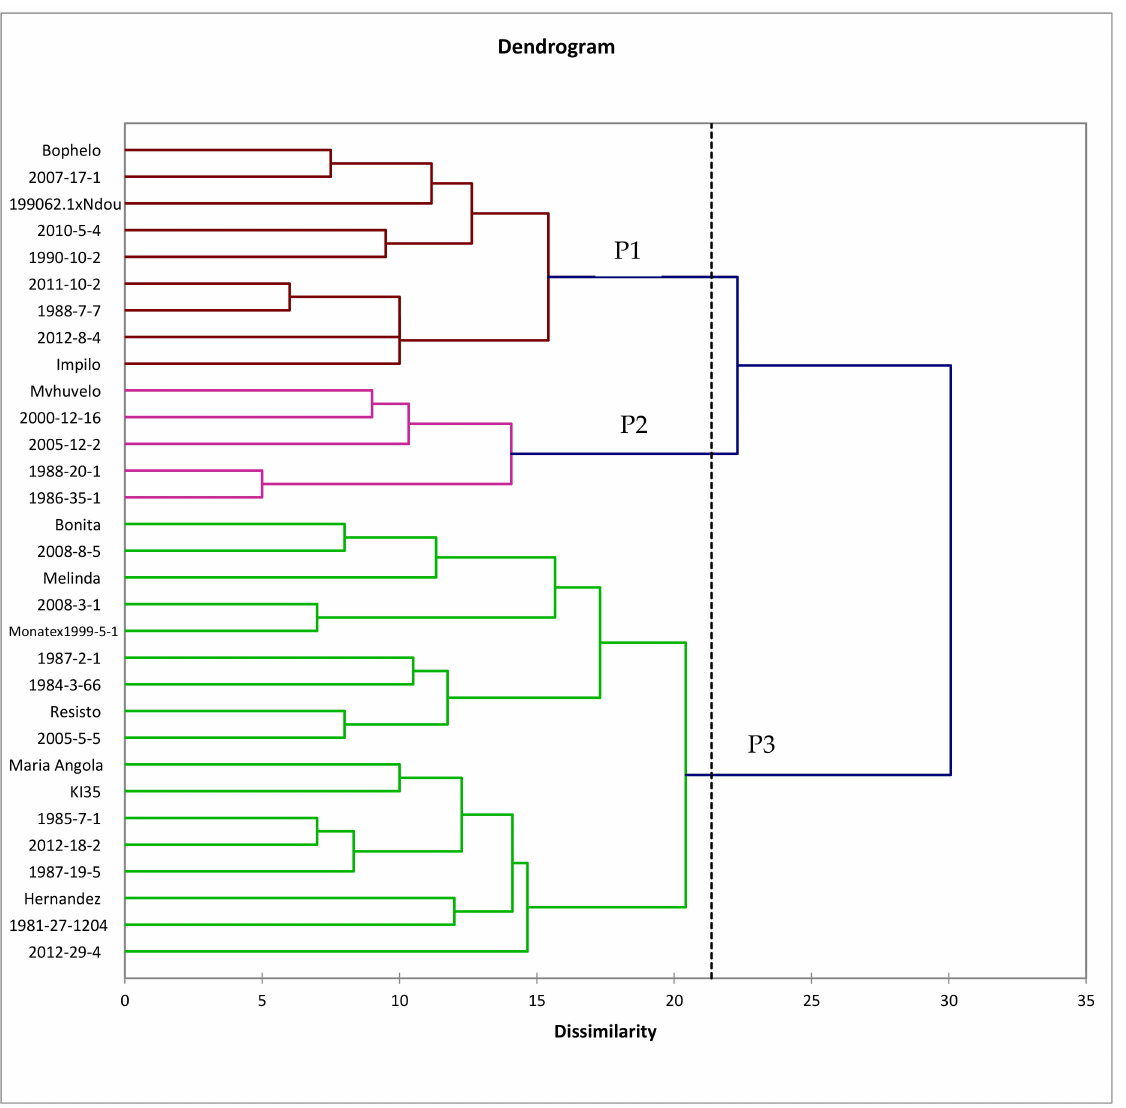
Figure 1. Agglomerative (Ward’s method) hierarchical clustering using Euclidean dissimilarity coefficient on 31 selected sweetpotato genotypes. P1, P2, to P3 denote Cluster 1, Cluster 2, and Cluster 3,